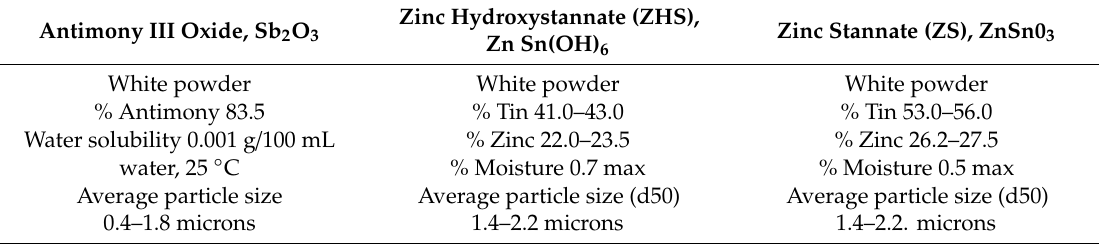
Table 3. Properties of commercial grades of antimony III oxide and zinc